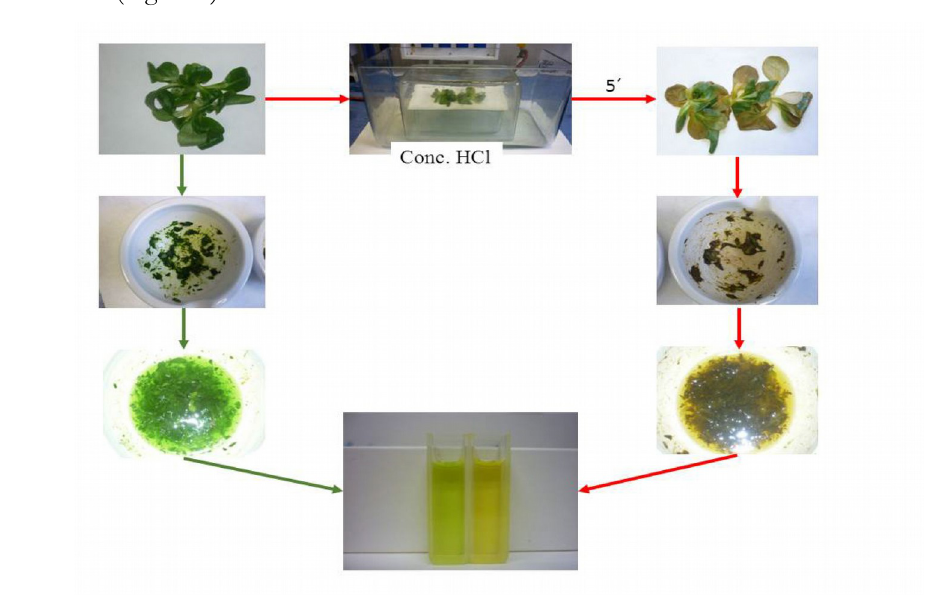
Figure 5. Alternative of